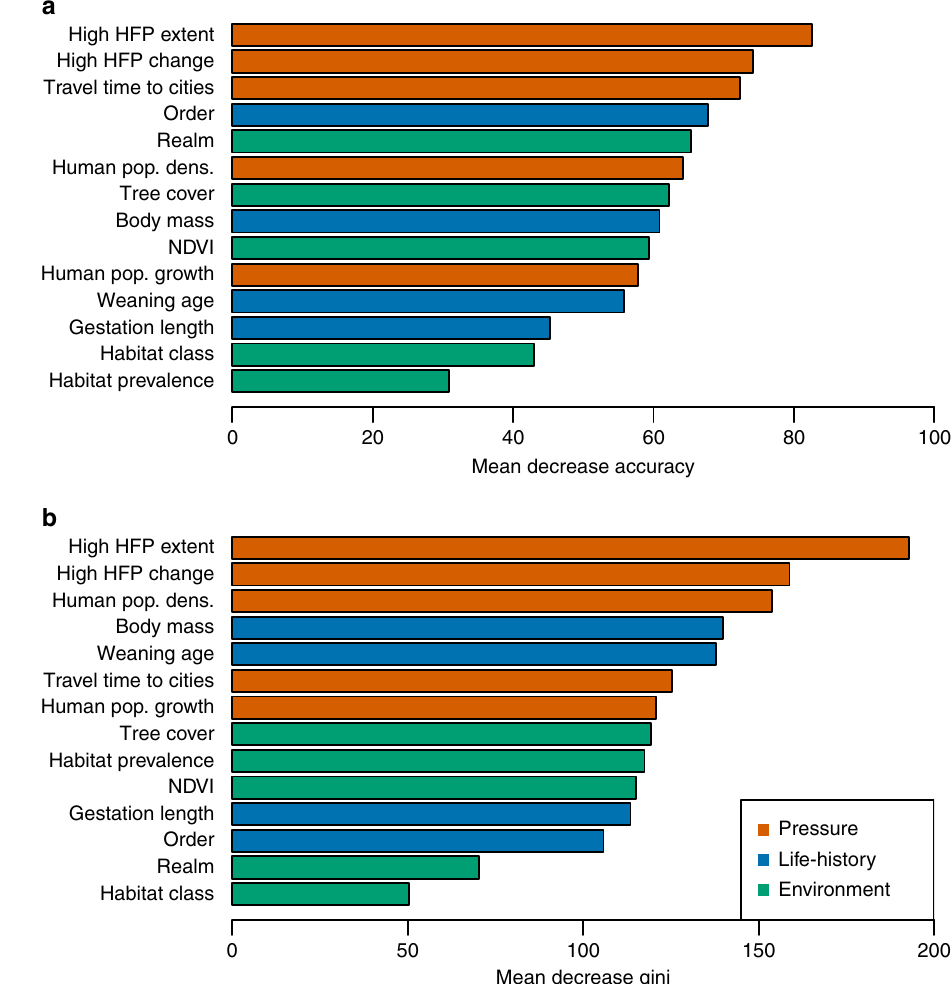
Fig. 5 Predictive importance of variables for the prediction of extinction risk transitions in terrestrial mammals. Variables are colour-coded according to their broad class (human pressure, life-history, environmental characteristics). Different plots refer to different measures of variable importance: a variable effect on the overall decrease in prediction accuracy, and b contribution of the variable to decrease Gini Index during the classi fi cation routine. A description of all the variables can be found in Table 1. In this analysis, “ high HFP" included values of 3 or